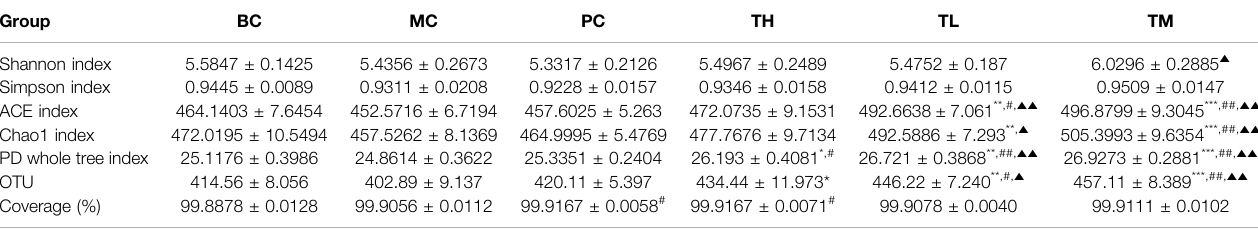
TABLE 2 | Alpha diversity statistics ( ‾ x±se, n = 9).